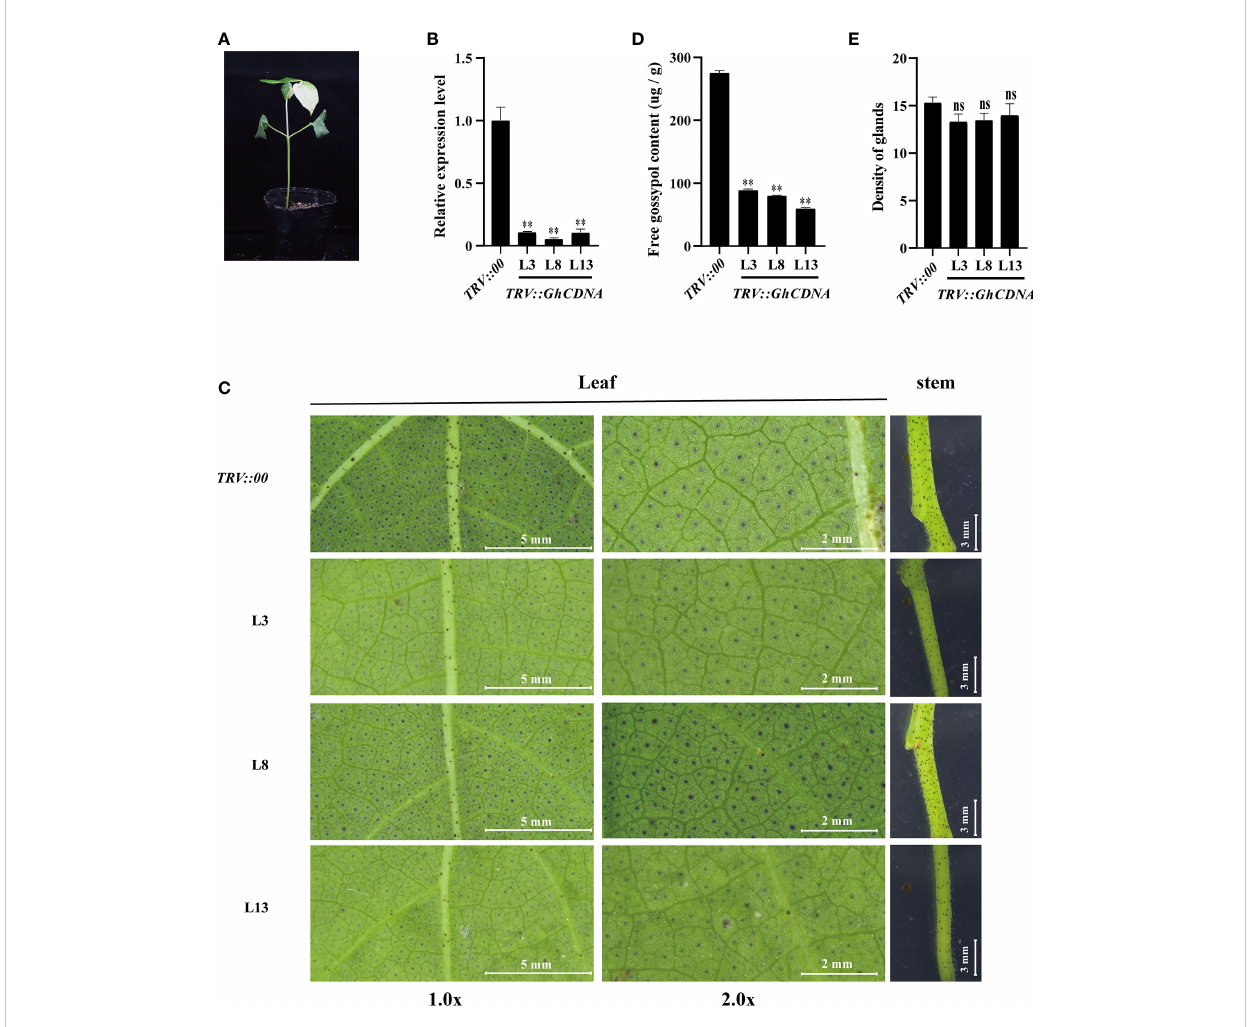
FIGURE 6 Knockdown of the GhCDNA subfamily genes reduced the gossypol content. (A) The phenotypes of TRV::PDS. (B) The silencing ef fi ciency of the GhCDNA subfamily genes in TRV::00 and TRV::GhCDNA plants. L3 , L8 , and L13 represented three different strains of TRV::GhCDNA plants. (C) The phenotypes of TRV::00 and TRV::GhCDNA plants. From left to right, the main vein area of cotton leaves was shown, the cotton leaves magni fi ed twice was shown, and the upper node area of cotton stem was shown, with the relative bar value in the lower right corner. (D) The gossypol content in TRV::00 and TRV::GhCDNA plants. (E) The density of glands TRV::00 and TRV::GhCDNA plants. Bars represent SDs (standard deviation) of three independent biological replicates. The single asterisk indicates statistical signi fi cance at P <0.05. The double asterisk indicates statistical signi fi cance at P